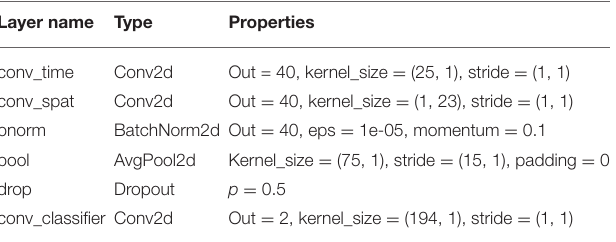
TABLE 1 | Shallow FBCSP Convolutional Neural Network structure (shallow FBCSP CNN) from Schirrmeister et al. (2017), implemented using the braindecode toolbox by Schirrmeister et al. (2017).